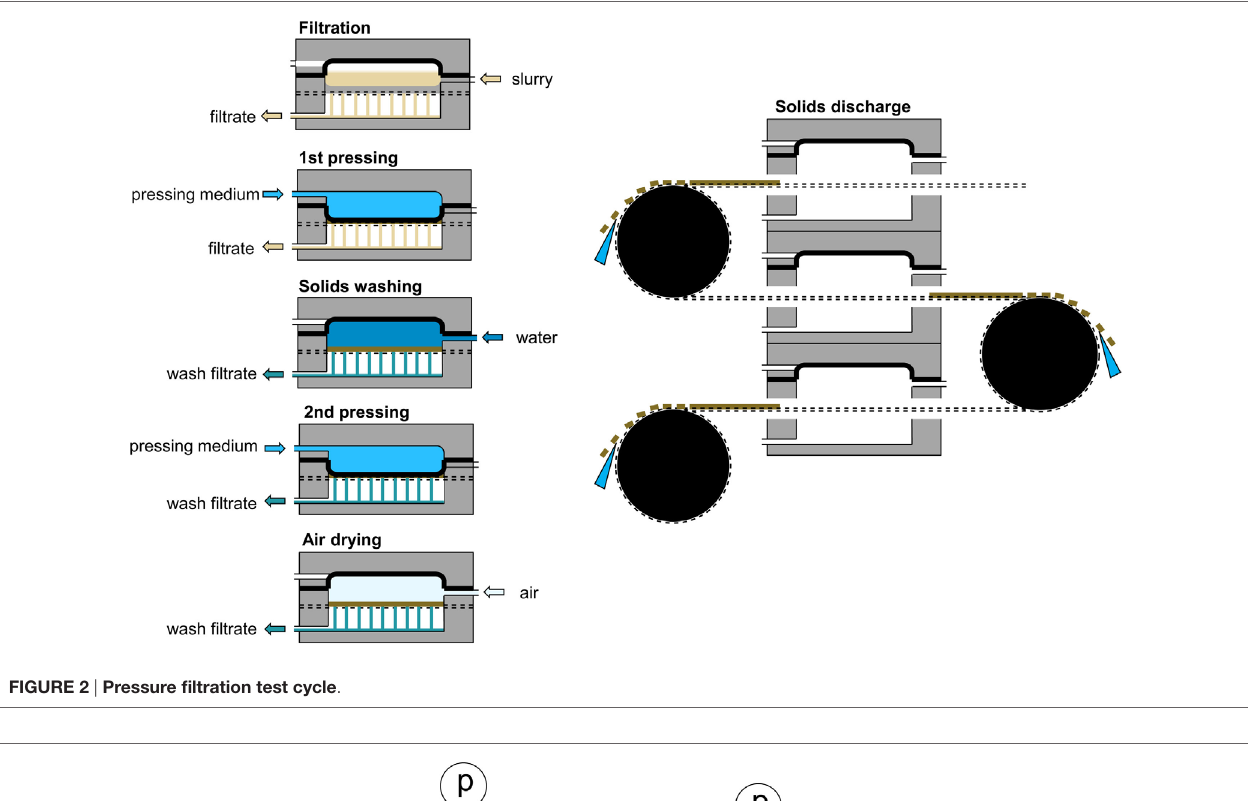
FigUre 2 | Pressure filtration test cycle